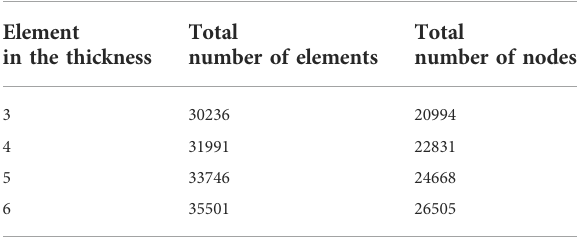
TABLE 2 Mesh data adopted in the mesh sensitivity